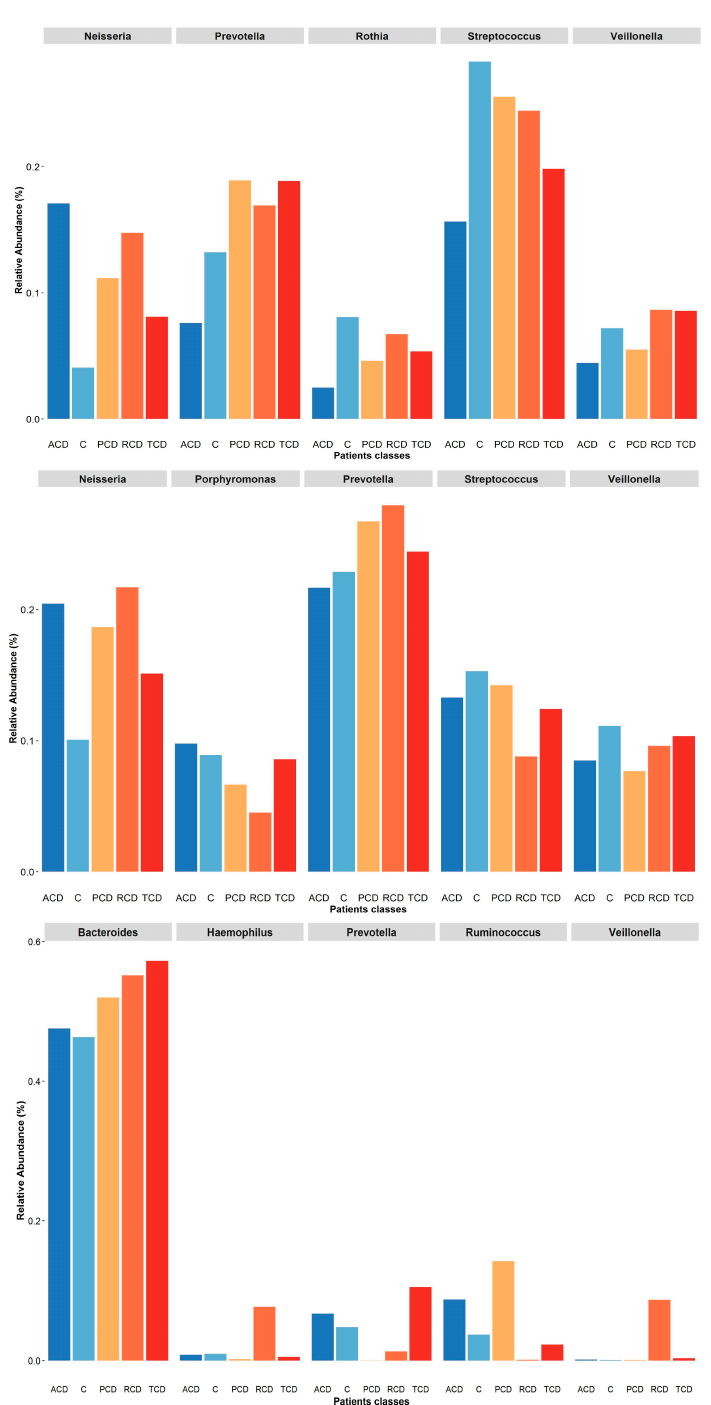
Figure 6. Plot of relative abundances of the five most abundant genera retrieved in each sample biotype: At the mucosal level (upper panel), all the most abundant genera are decreased in the ACD group but Neisseria as in all the other celiac groups with respect to the C one. Interestingly, Prevotella abundance is increased in the PCD, RCD, and TCD groups. In the salivary samples (central panel), again, Neisseria abundance is critically increased in all celiac groups with respect to the C one while Prevotella is increased only in the PCD, RCD, and TCD groups. Finally, in the stool samples (lower panel), the most abundant genus is Bacteroides that is increased in all celiac groups, with the other genera showing negligible values. Notably, the Haemophilus and Veillonella genera are critically increased only in the RCD group while the Prevotella is absent in the PCD group that displays a robust increase of the Ruminococcus as in the ACD